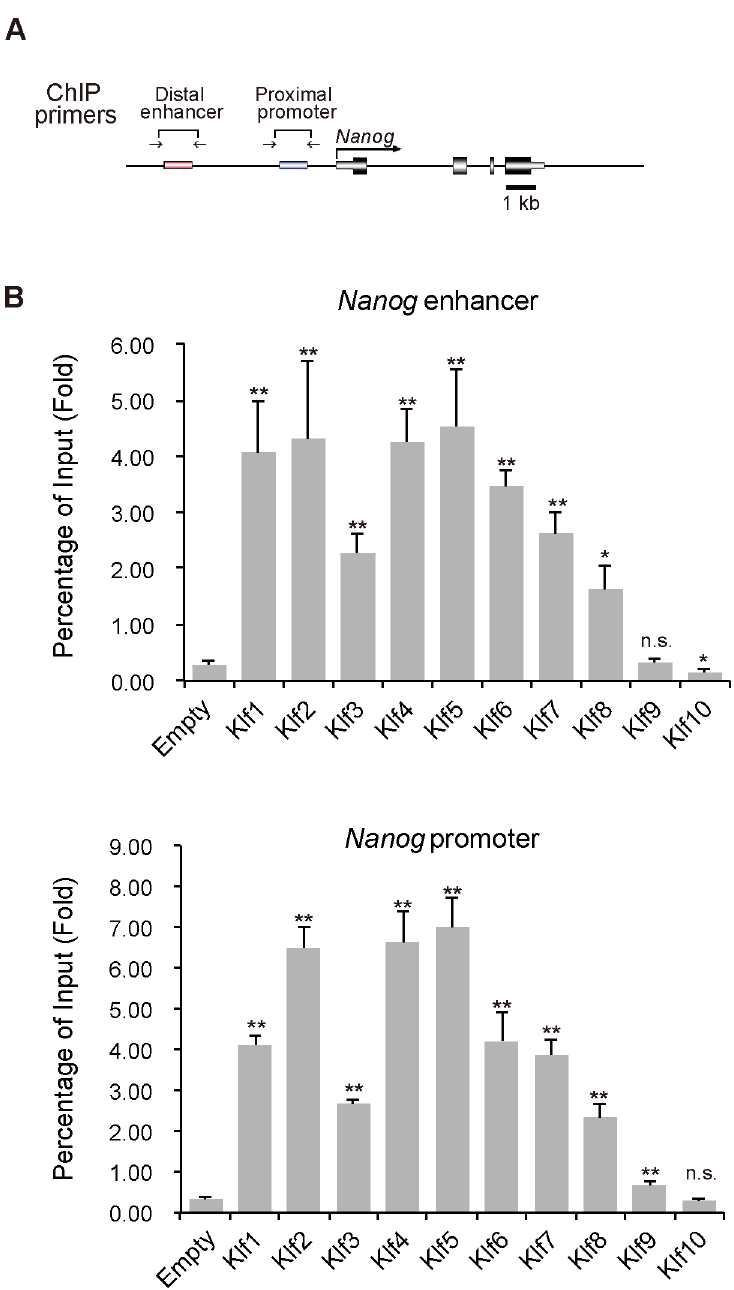
Fig 3. ChIP analysis of the binding of epitope-tagged Klf to Nanog regulatory regions in mouse ES cells. (A) Schematic representation of the Nanog proximal promoter and distal enhancer. Two key regulatory regions (the enhancer and proximal promoter) of Nanog are shown as red and blue bars, respectively. Horizontal arrows indicate the primers used for PCR in site-specific ChIP assays. (B) ChIP analysis of the binding of Klf to the promoter and enhancer of Nanog . Asterisks indicate statistical significance. * P < 0.05; ** P < 0.01; n.s.; not